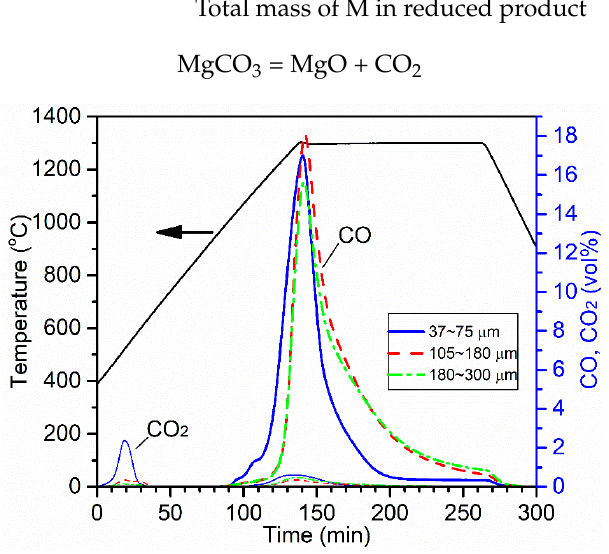
Figure 10. Temperature profiles, off-gas CO, and CO 2 concentrations for the tests with the variation of chromite particle size.